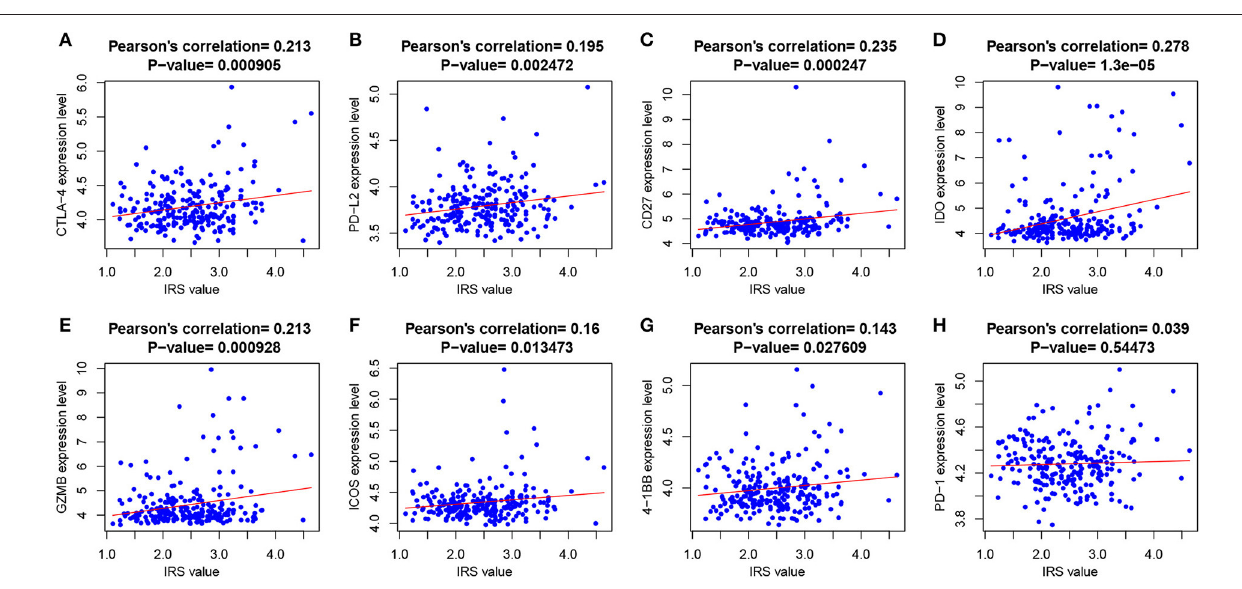
FIGURE 4 | The correlations between IRS and (A) CTLA-4; (B) PD-L2; (C) CD21; (D) IDO; (E) GZMB; (F) ICOS; (G) 4-1BB; and (H)